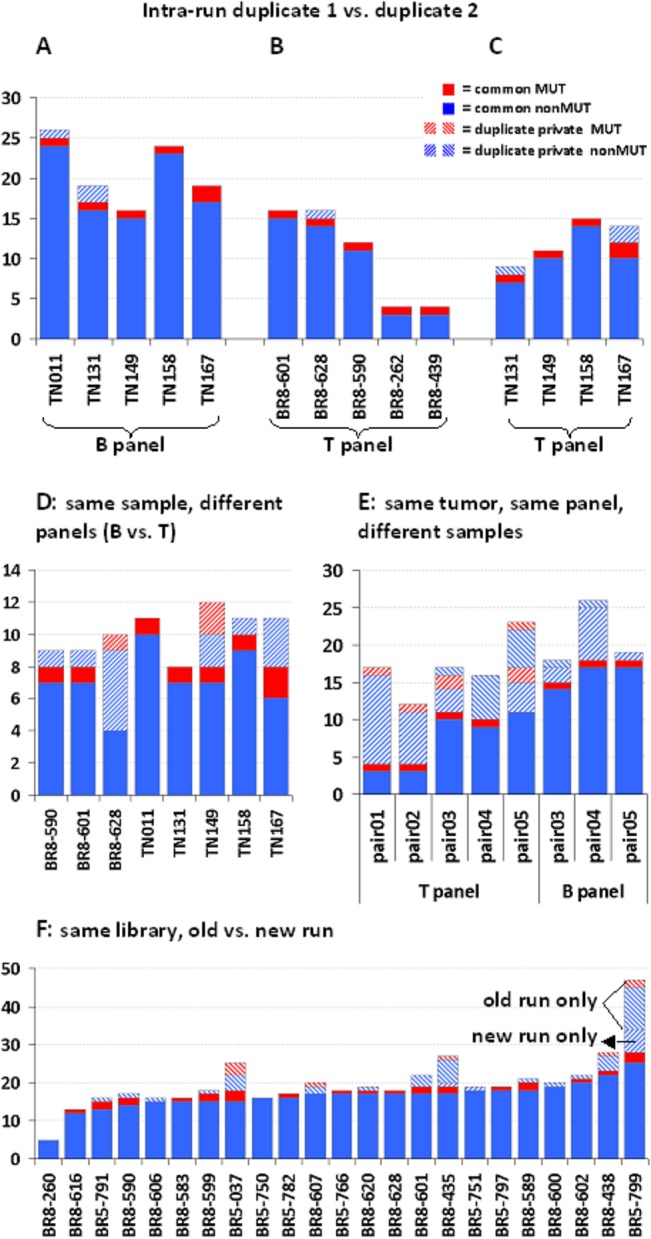
Variant concordance in FFPE samples.For all graphs, solid color boxes represent concordant, whereas striped boxes represent discordant variants. Red color stands for MUT variants (amino acid changing, excluding TP53 p.P72R) and blue for nonMUT (non amino acid changing, coding and non-coding). Opposite directions of stripes stand for each paired sample. A: Five TN samples with the B panel. B: Five BR samples with the T panel. C: Four TN samples with the T panel (out of five on trial, one was ineligible). D: Panel comparison for the same sample. Only common and shifted amplicons in the two panels were evaluated. E: Different samples from the same tumor revealed distinct genotypes when tested with the same panel. F: Comparison between genotypes from subsequent runs performed 6 months apart for BR samples with the B panel. Old run only, new run only: patterns apply to all columns in this graph.